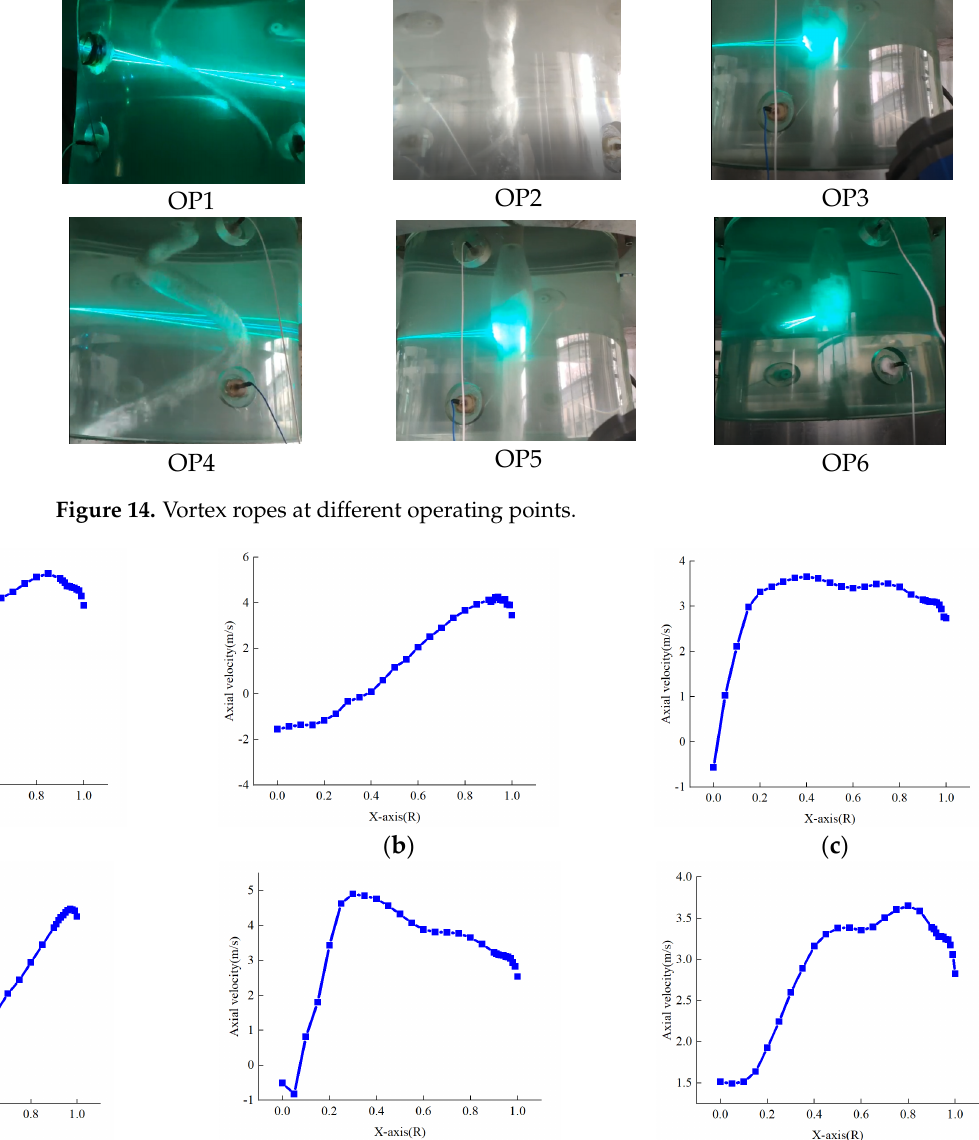
Figure 15. Trend of axial velocity distribution on the x-axis. ( a ) OP1, ( b ) OP2, ( c ) OP3, ( d ) OP4, ( e ) OP5, and ( f ) OP6.